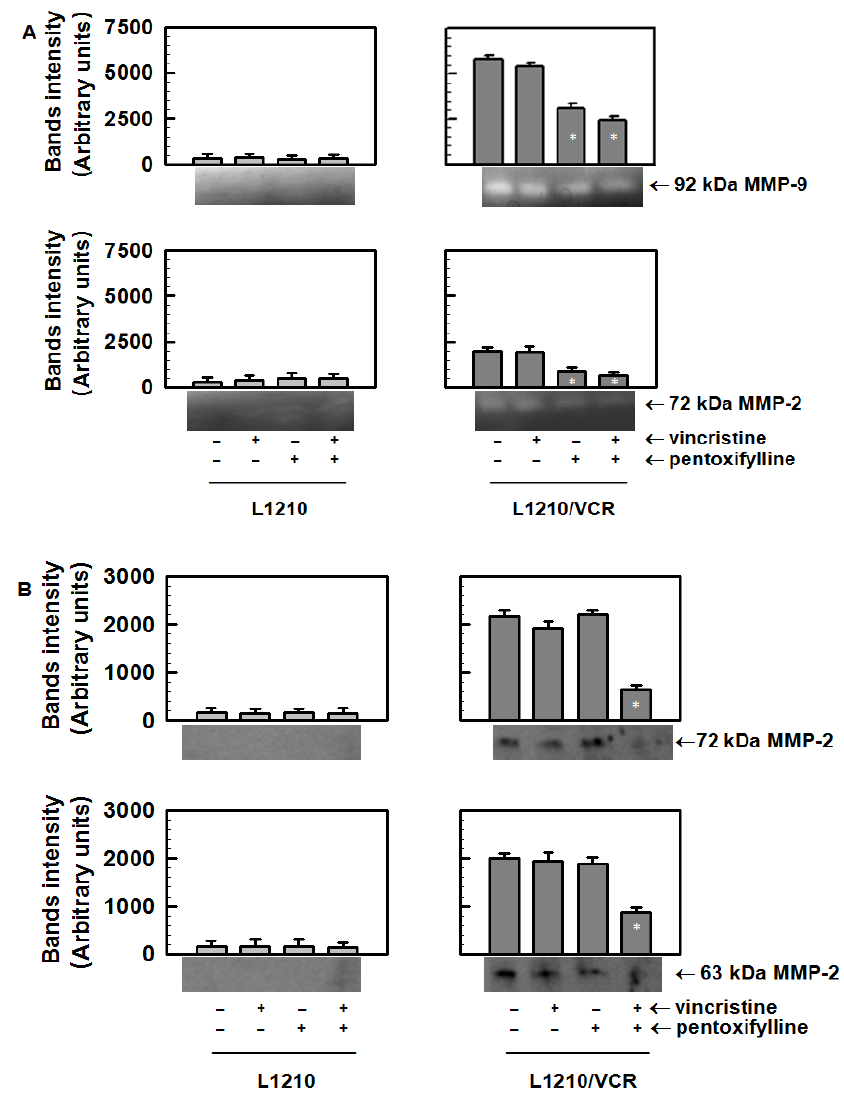
Figure 5. Effects of VCR and PTX treatment on the secretion of matrix metalloproteinases from sensitive L1210 and resistant L1210/VCR cells into the external